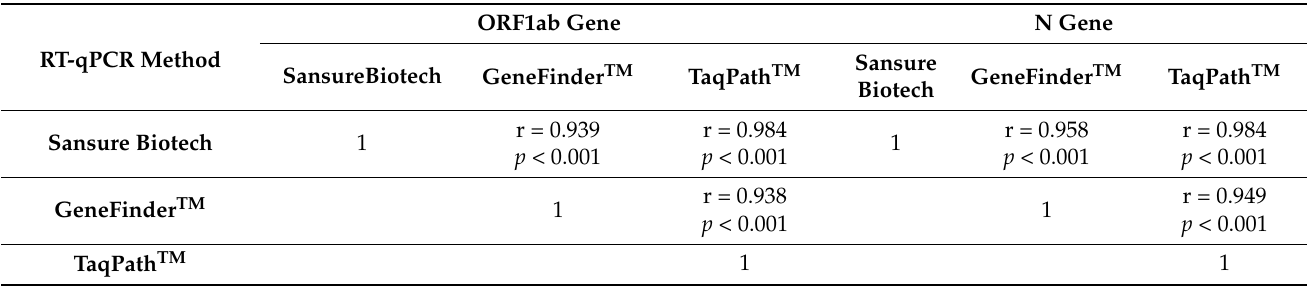
Table 4. Correlation matrix for the association between Ct values obtained by the three RT-qPCR